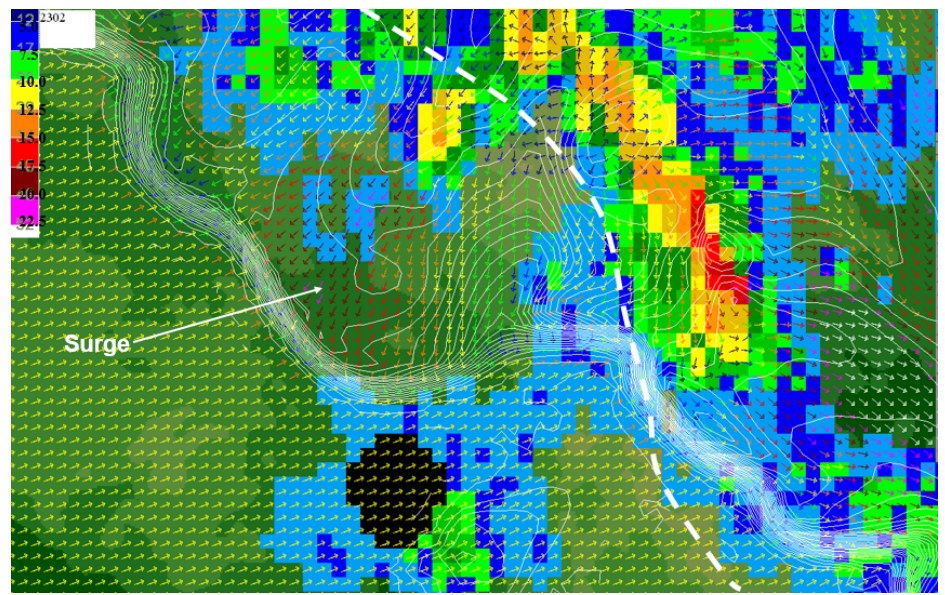
Figure 11. Same as for Figure 9 but valid for 1600 LST.